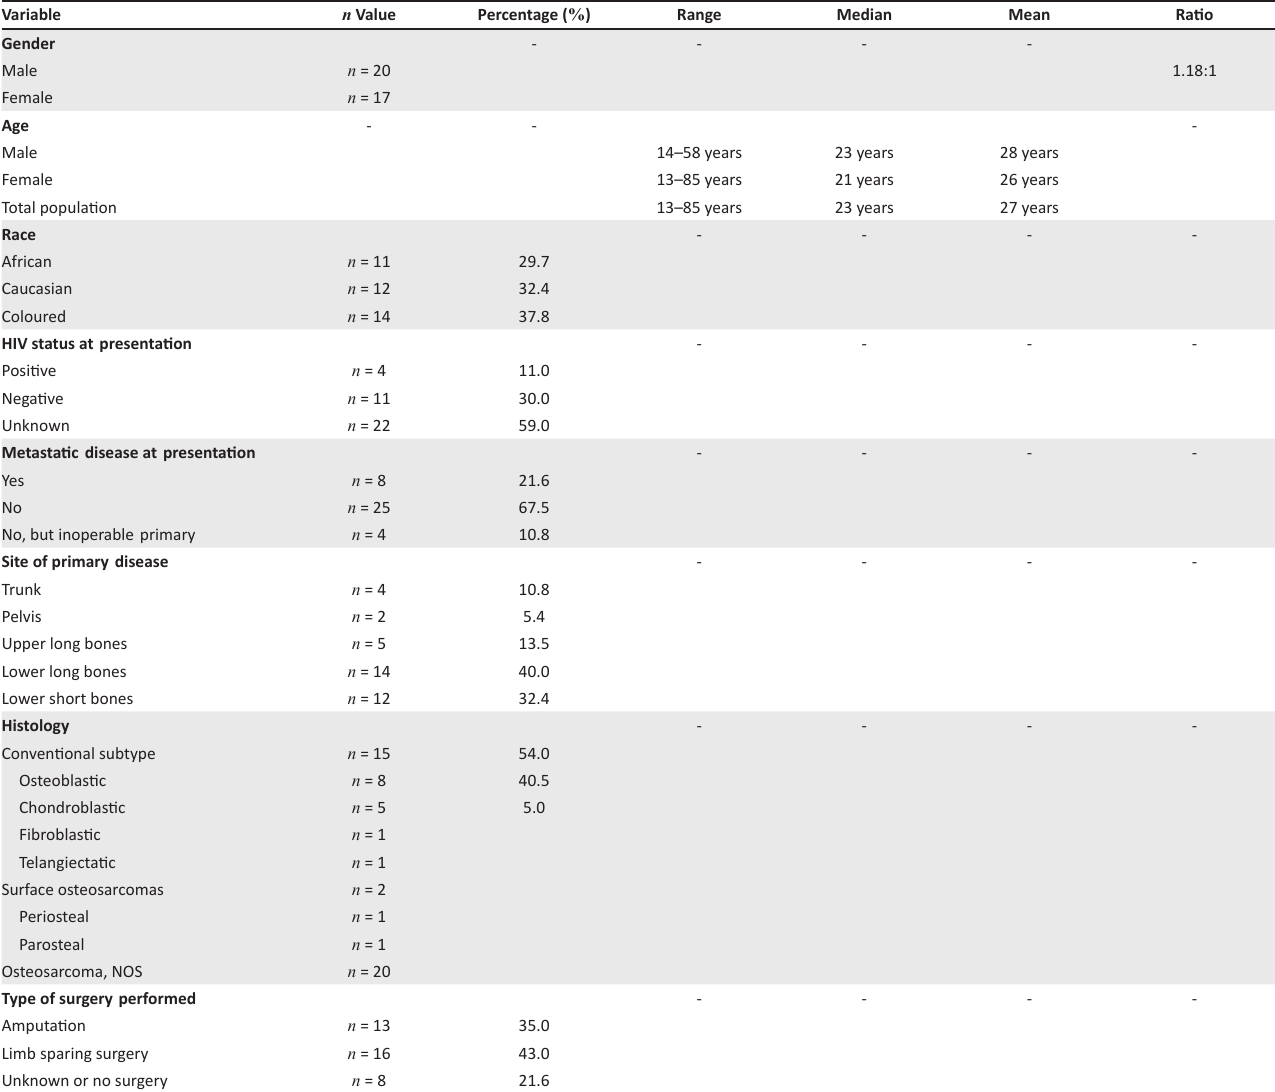
TABLE 1: Demographic data of study